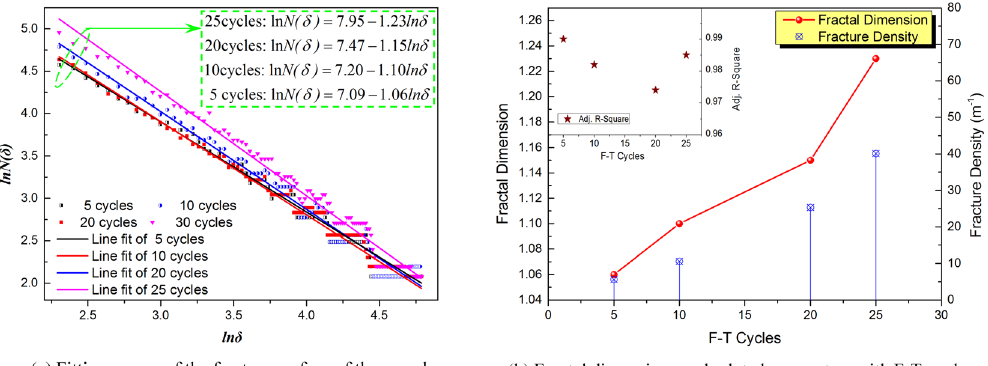
Figure 5. Fractal dimension of the coal freeze-thaw cycle fracture